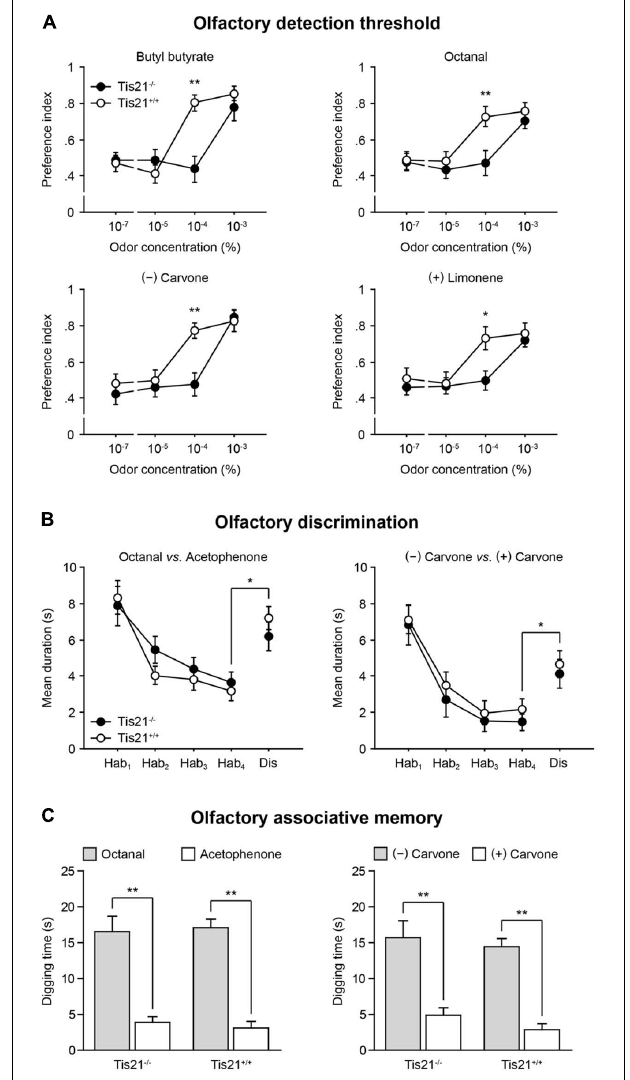
FIGURE 9 | Impaired olfactory detection in Tis21 knockout mice. (A) An olfactory detection threshold was determined by exposing the animals to series of progressively increasing concentrations of different odorants, in separate sessions, and measuring the time they spent investigating the odors vs. odorless mineral oil.Wild-type mice were able to detect the odors at a concentration equal to, or greater than, 10 − 4 %, whereas Tis21 knockout mice detected odors only at a concentration of 10 − 3 %. ** p < 0.01 and * p < 0.05 vs. wild-type. (B) The animals’ ability to discriminate between different or similar odors was analyzed by a habituation-dishabituation test, in which they were repeatedly exposed to one odor [octanal, or ( − ) carvone], during the habituation phase, and finally exposed to a different one [acetophenone, or ( + ) carvone] during the dishabituation trial. A significant increase of the sniffing time in the presence of the novel odor indicated normal discrimination, for both wild-type and Tis21 knockout mice. Hab, habituation; Dis, dishabituation. * p < 0.05 vs. Hab-4. (C) Long-term, odor-reward, associative memory was evaluated by training for 4 days the animals to associate one odor [octanal, or ( − ) carvone] to a food reward, and then, on day five, the time they spent digging at the reinforced odor was compared to an unreinforced one [acetophenone, or ( + ) carvone]. In this test, both wild-type and Tis21 knockout mice demonstrated a strong learning of the reinforced association. ** p < 0.01 vs. unreinforced. Data are mean ±